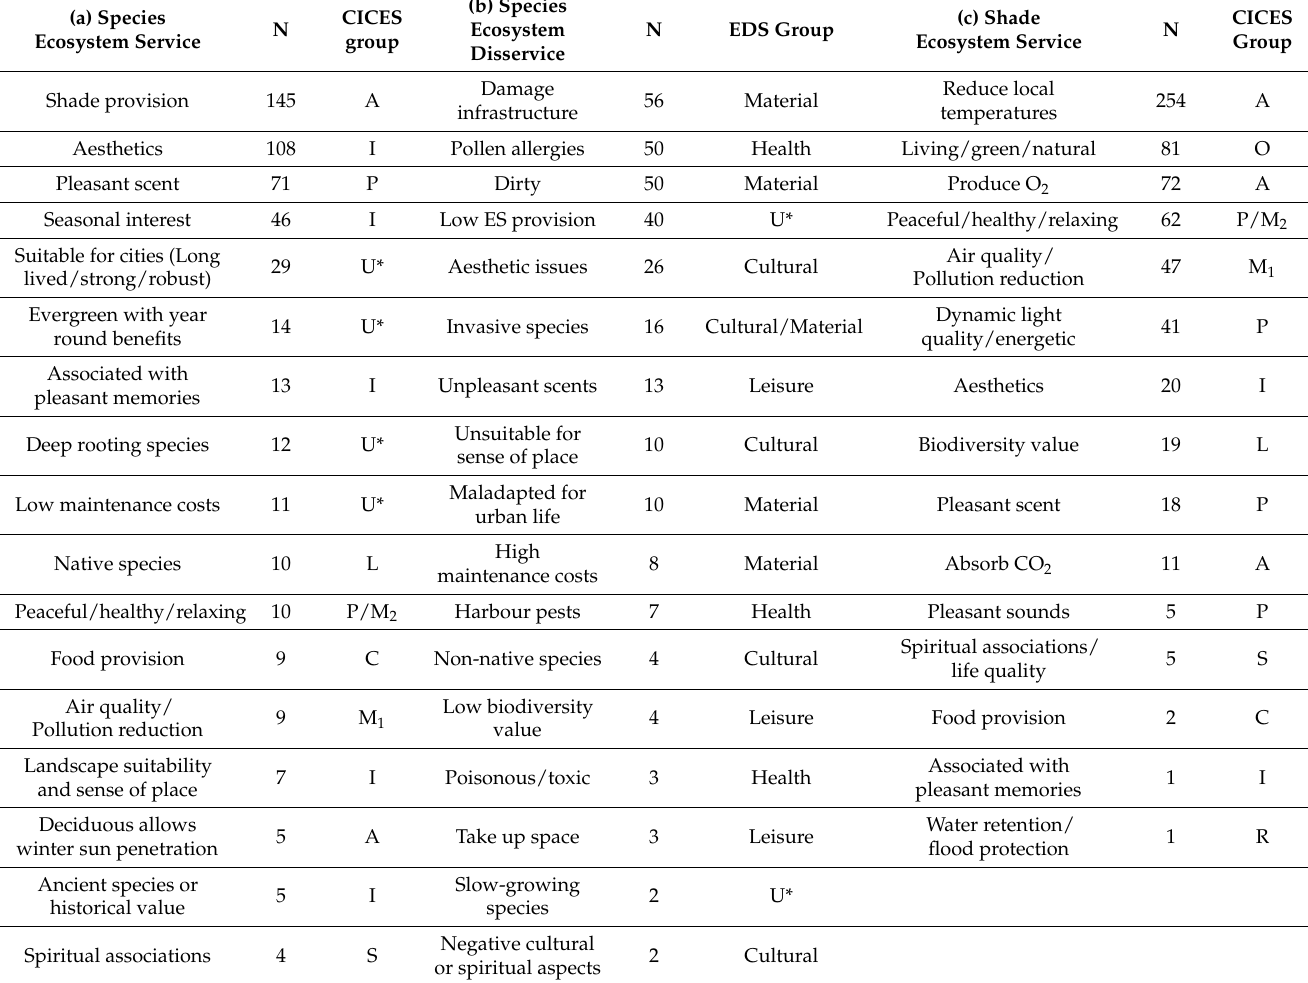
Table 2. Frequency table for the coded responses to open questions regarding (a) favourite urban tree species, (b) least favourite species and (c) the difference between the shade of a tree and that of a